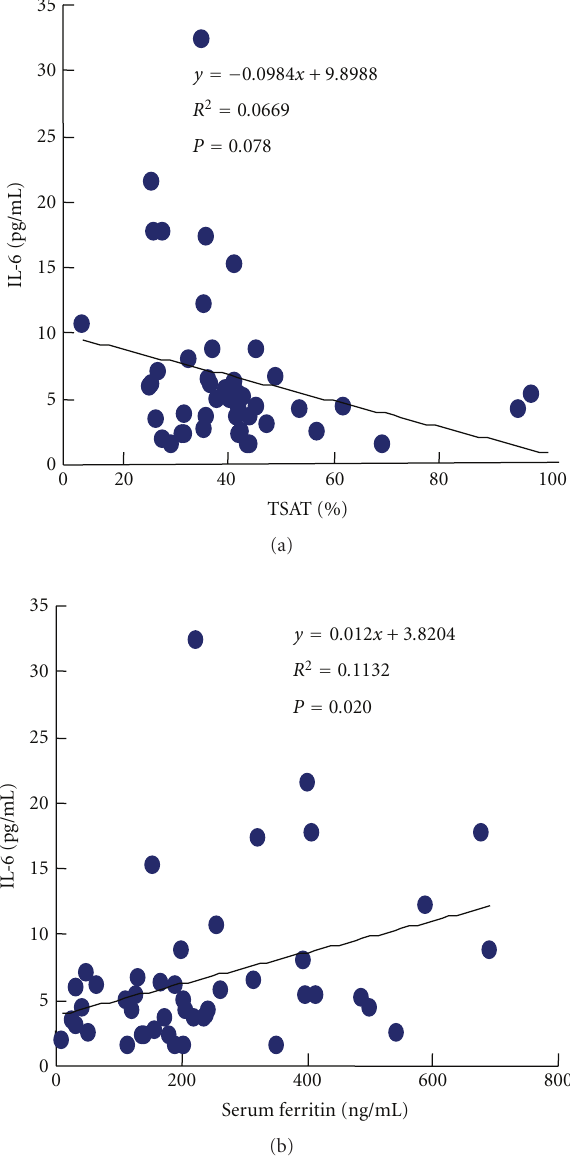
Figure 6: Correlation between serum IL-6 levels and iron parame- ters. (a) IL-6 and TSAT, (b) IL-6 and serum